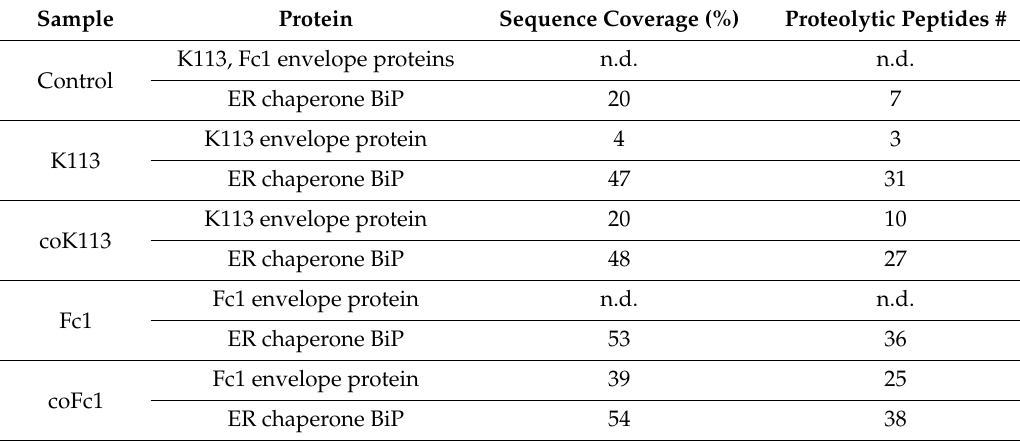
Table 1. Sequence coverage and proteolytic peptides identified by LC-MS / MS for expressed HERV proteins and the ER chaperone